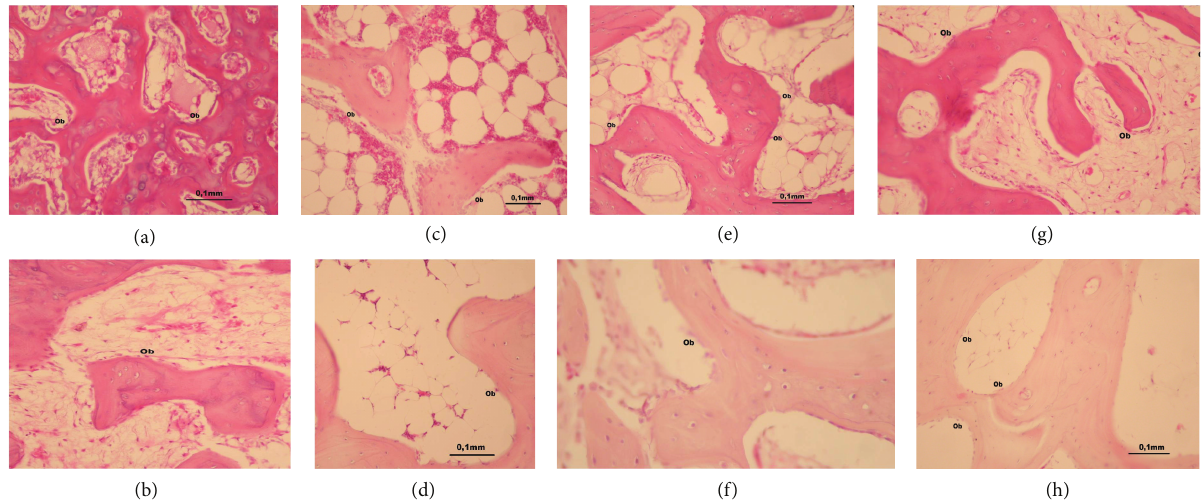
Figure 5: Images of hematoxylin-eosin-stained sections captured under light microscopy for loaded ((a) Group I; (c) Group II; (e) Group III; (g) Group IV) and unloaded ((b) Group I C ; (d) Group II C ; (f) Group III C ; (h) Group IV C ) groups.